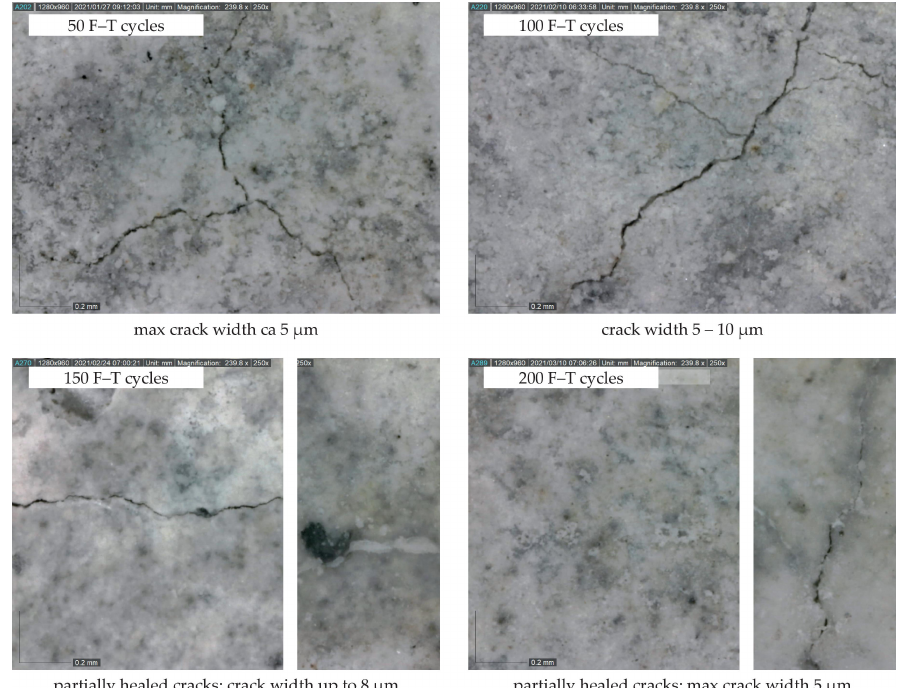
Figure 8. Microcracks on the specimen surface (C2; magnification 250 × ).